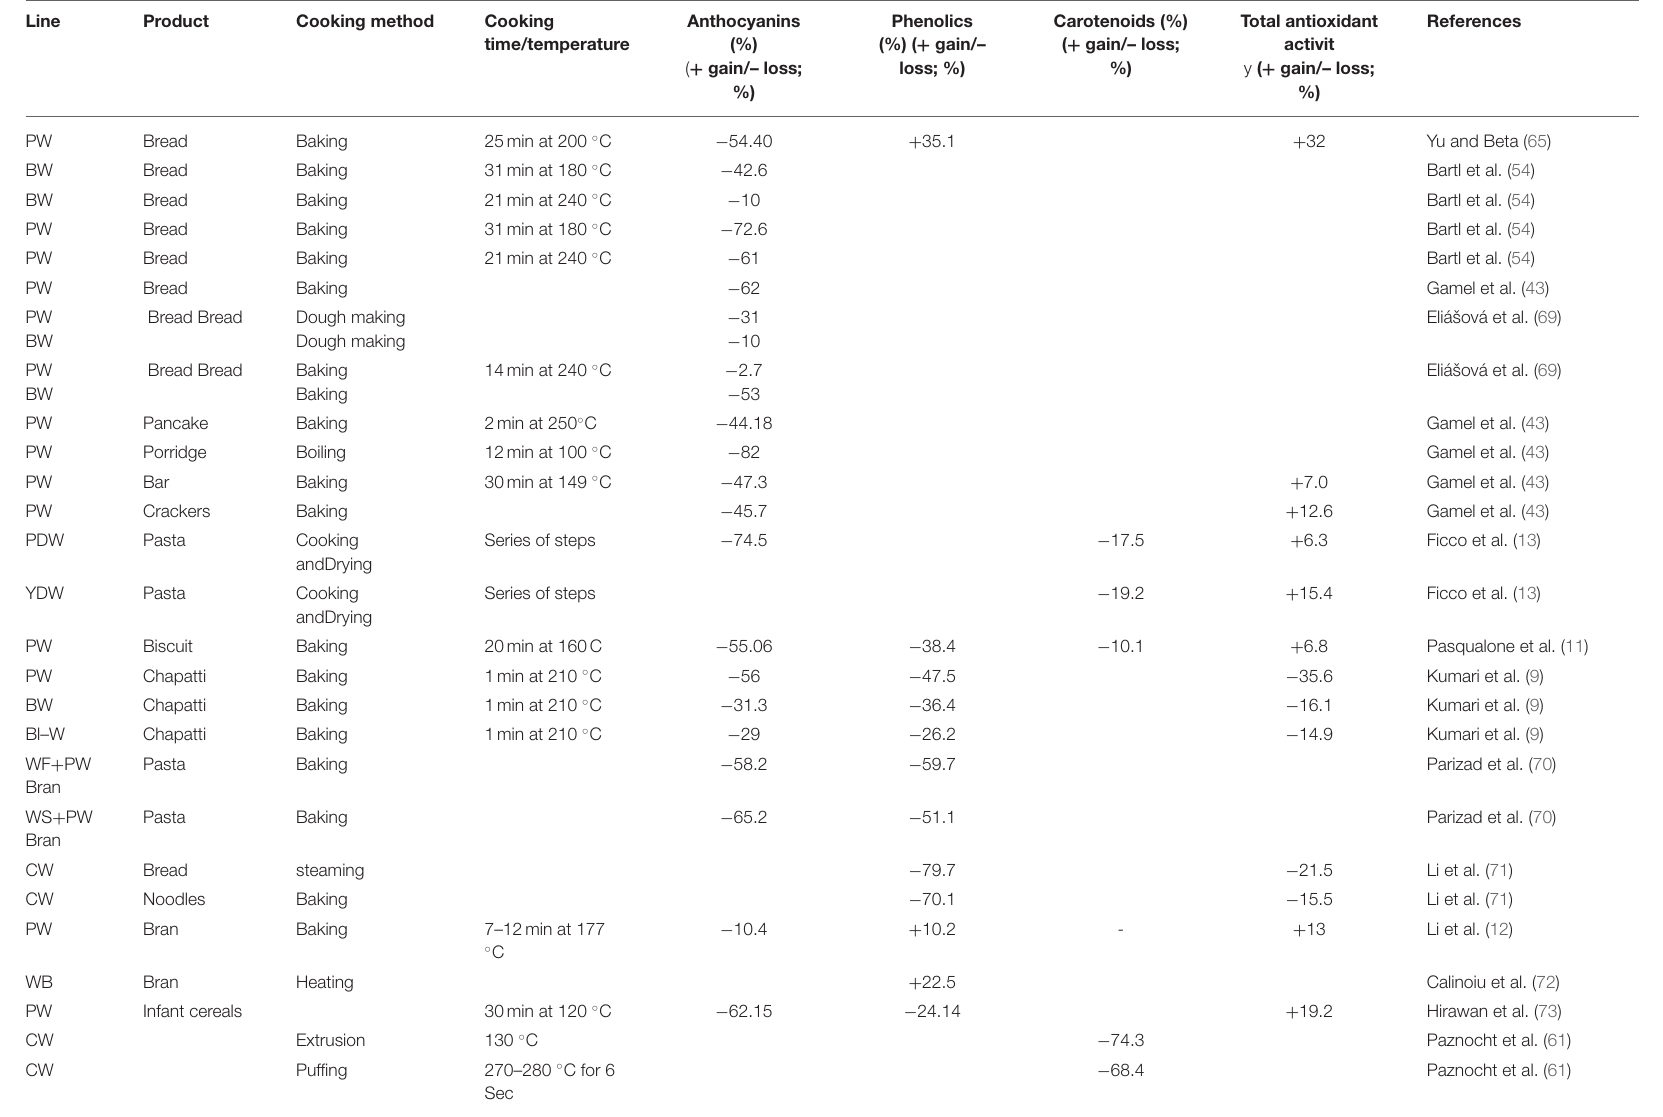
TABLE 2 | Cooking induced changes in the anthocyanins, phenolics, carotenoids, and antioxidant activities of colored wheat. Line